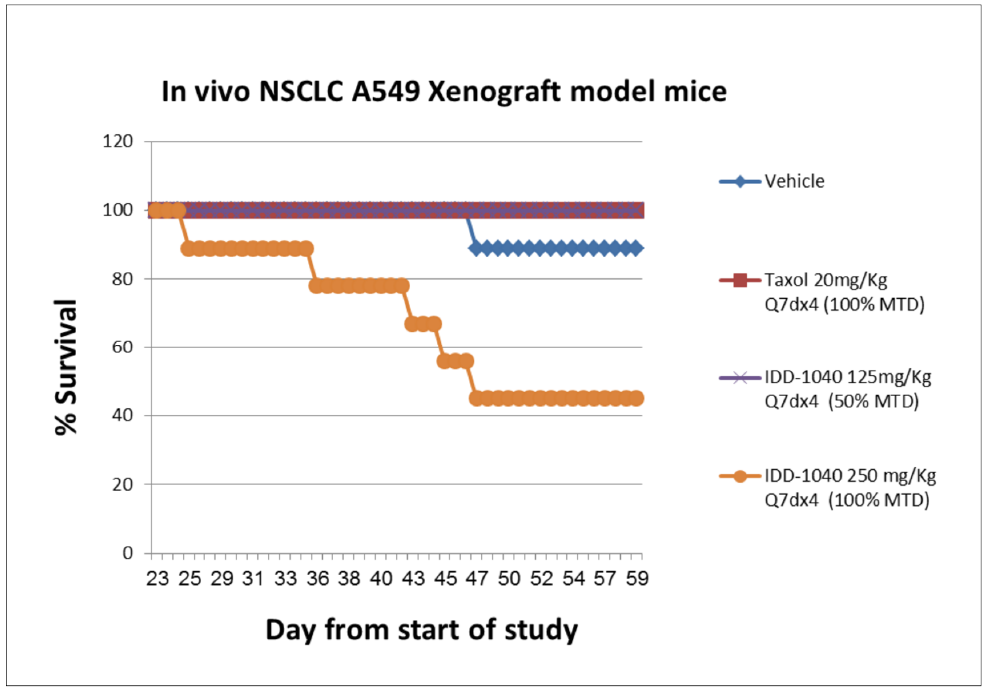
Figure 7. Animal survival and mortality curves following the IV administration of IDD-1040, Taxol (paclitaxel), and vehicle in an in vivo A549 NSCLC xenograft study in mice. Animals were treated with vehicle, PTX (at 100% of the MTD), IDD-1040 (at 50% of the MTD), and IDD-1040 (at 100% of the MTD), administered weekly for four weeks.